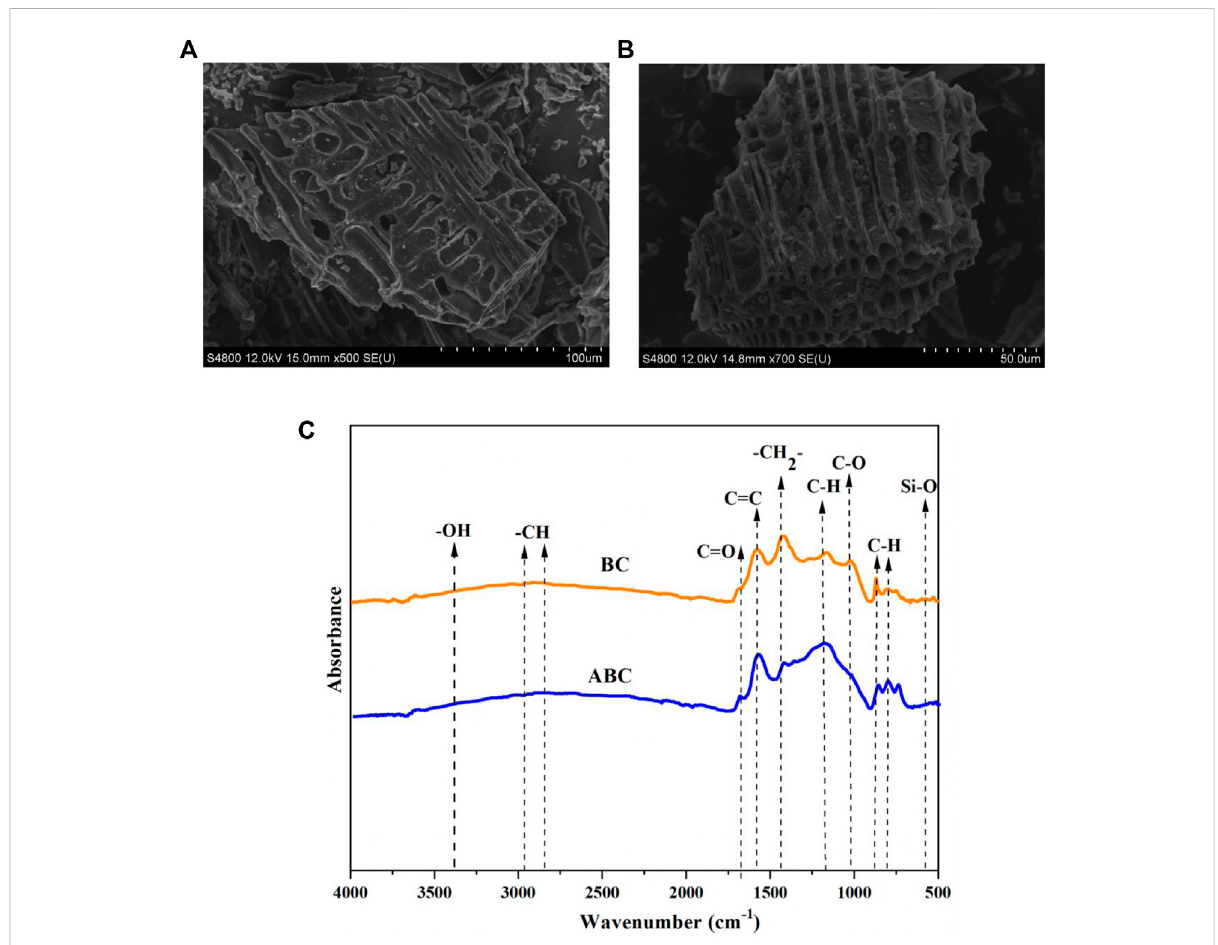
FIGURE 1 SEM images of the sawdust-derived biochar (BC) (A) and acid-modi fi ed biochar (ABC) (B) . FTIR spectra of biochar (C)